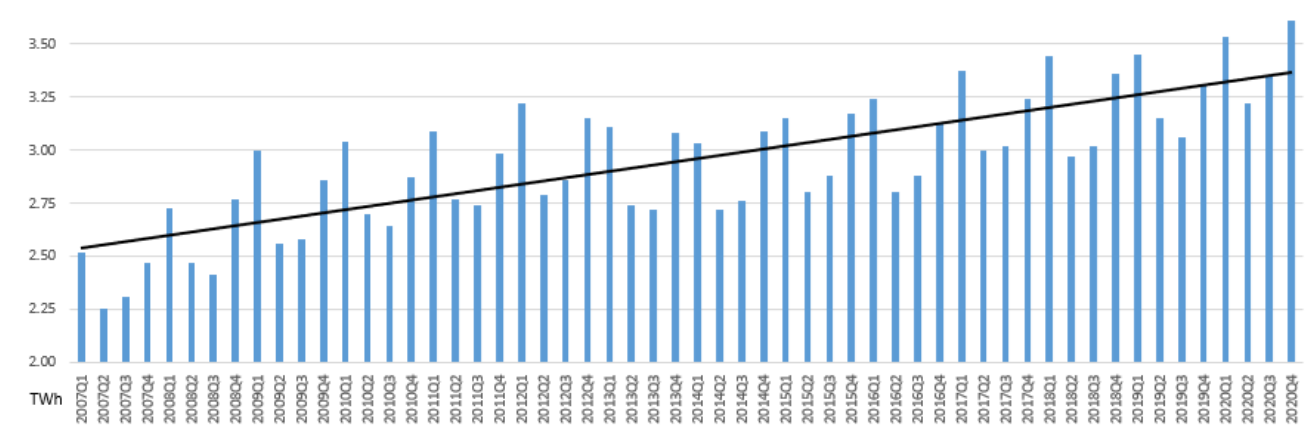
Figure 4. The evolution of household electricity consumption during the period 2007–2020.